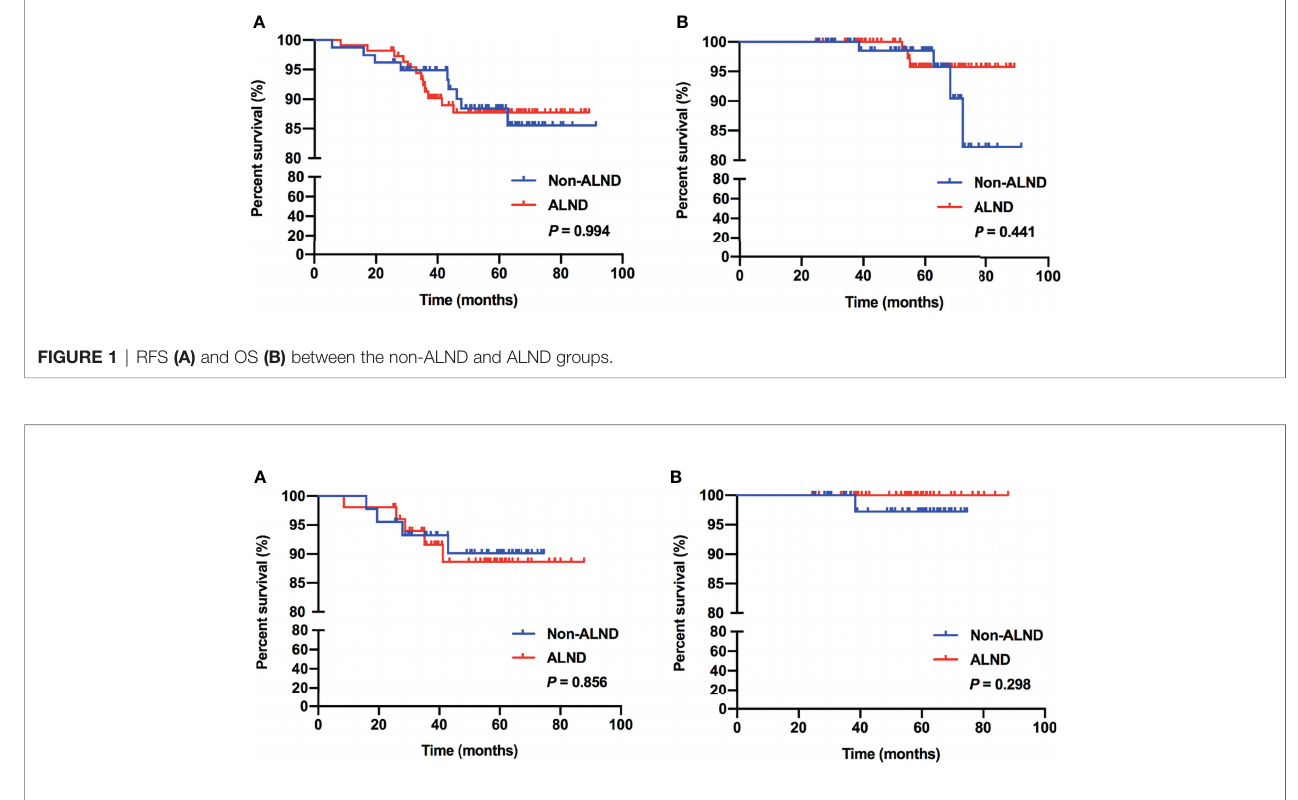
FIGURE 2 | RFS (A) and OS (B) in patients who met the inclusive criteria of the IBCSG 23-01 trial.